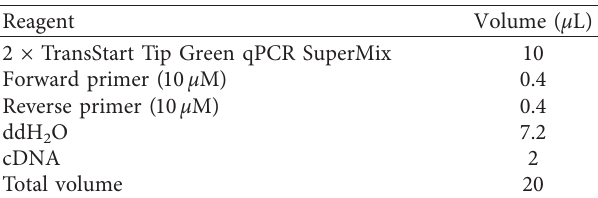
Table 3: Real-time fluorescence-based quantitative PCR (qRT- PCR)